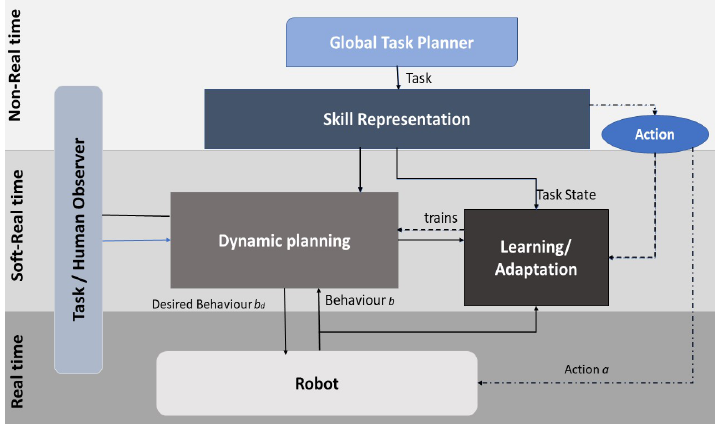
Figure 4. Interactive collaborative control